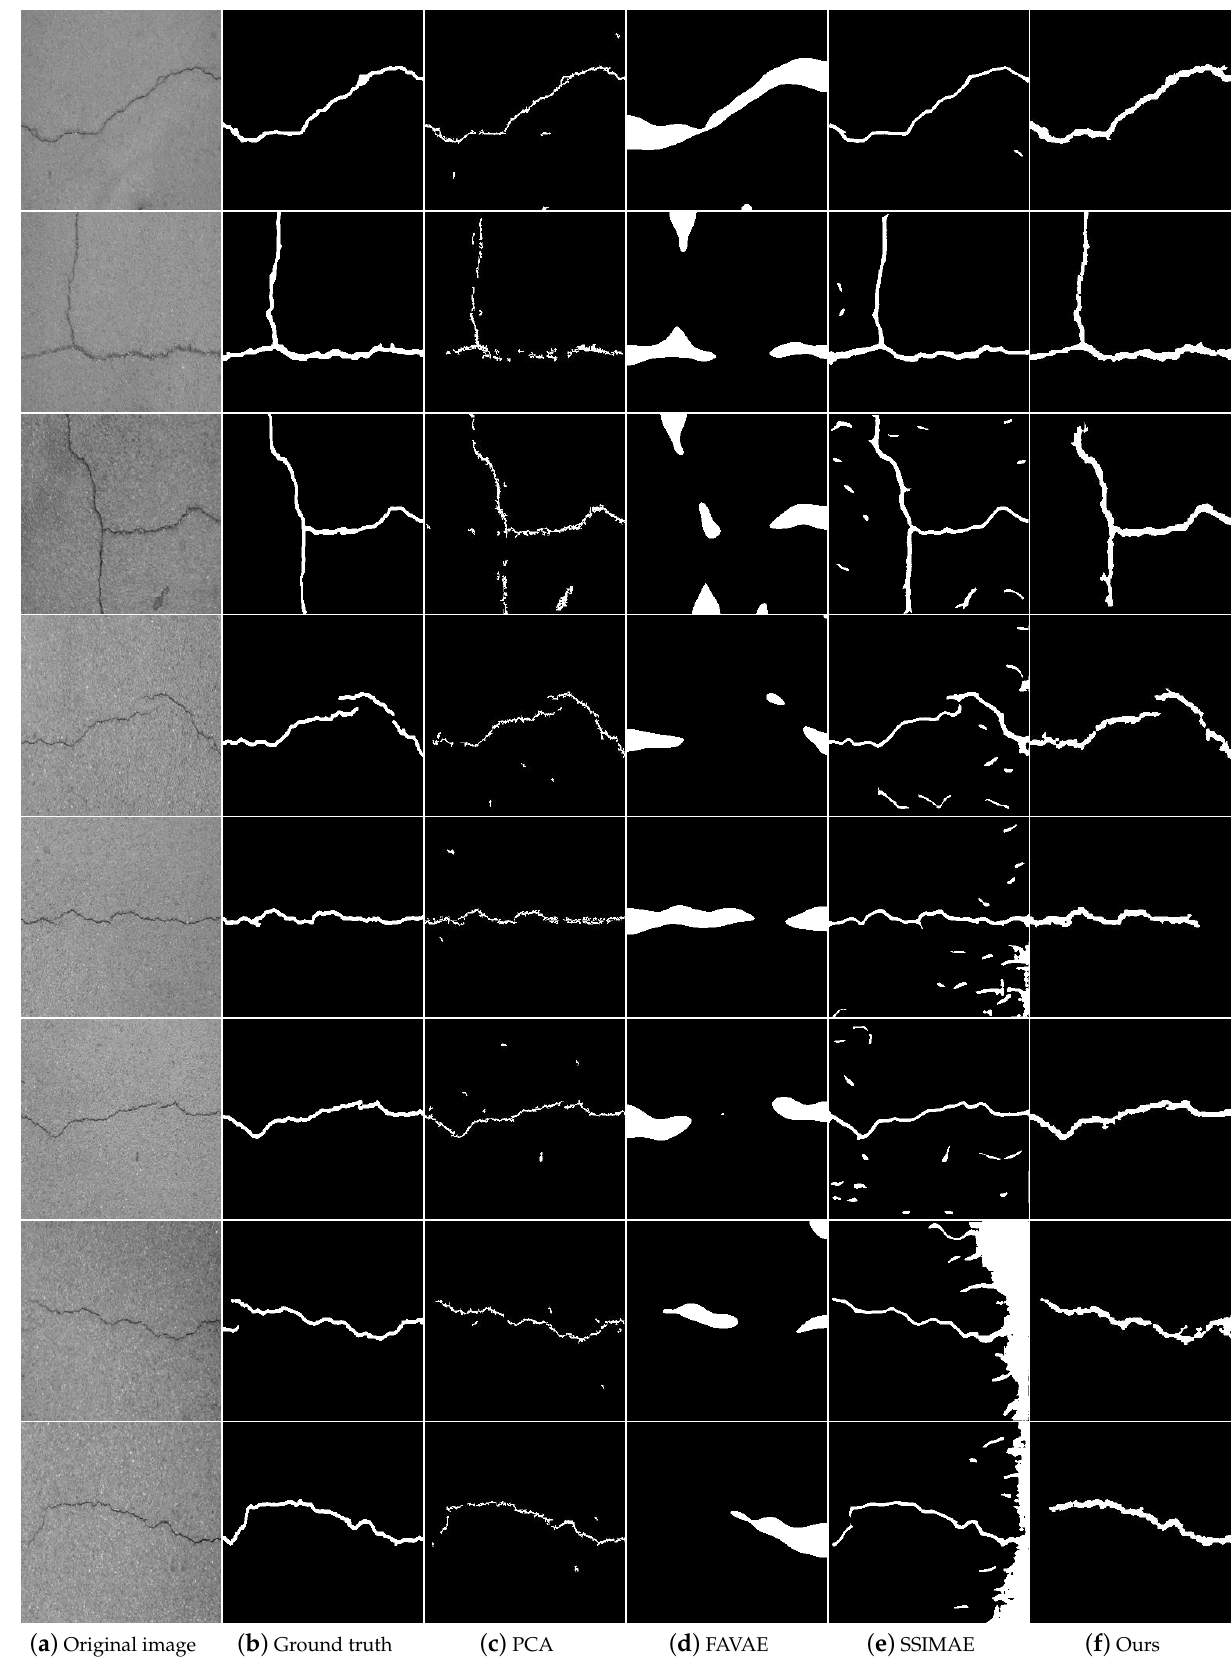
Figure 5. The results of different approaches on